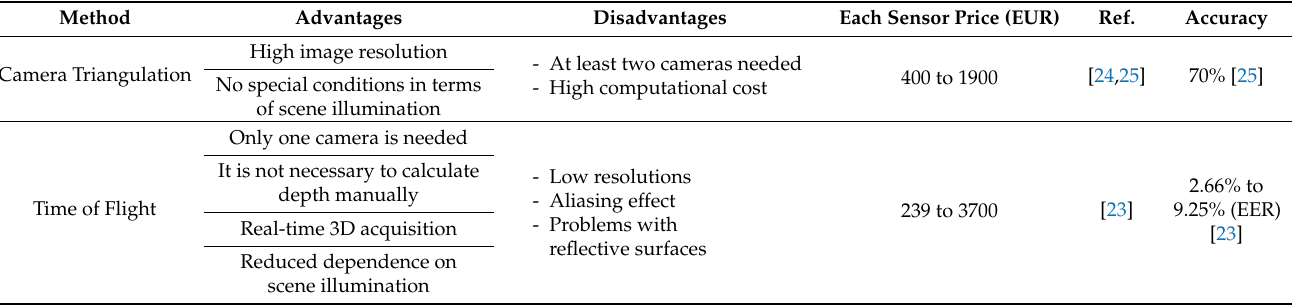
Table 1. Comparison of optical systems based on depth measurement